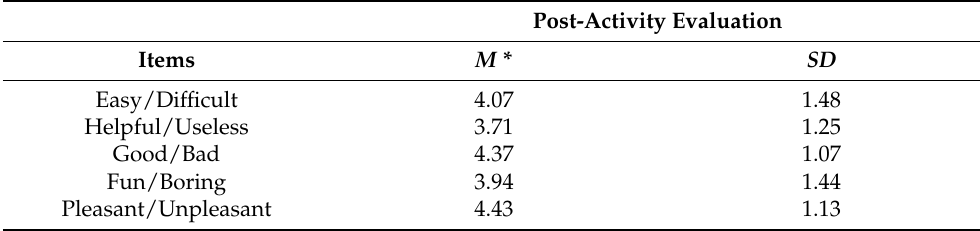
Table 2. Evaluation of the activity (B2): descriptive statistics ( N =